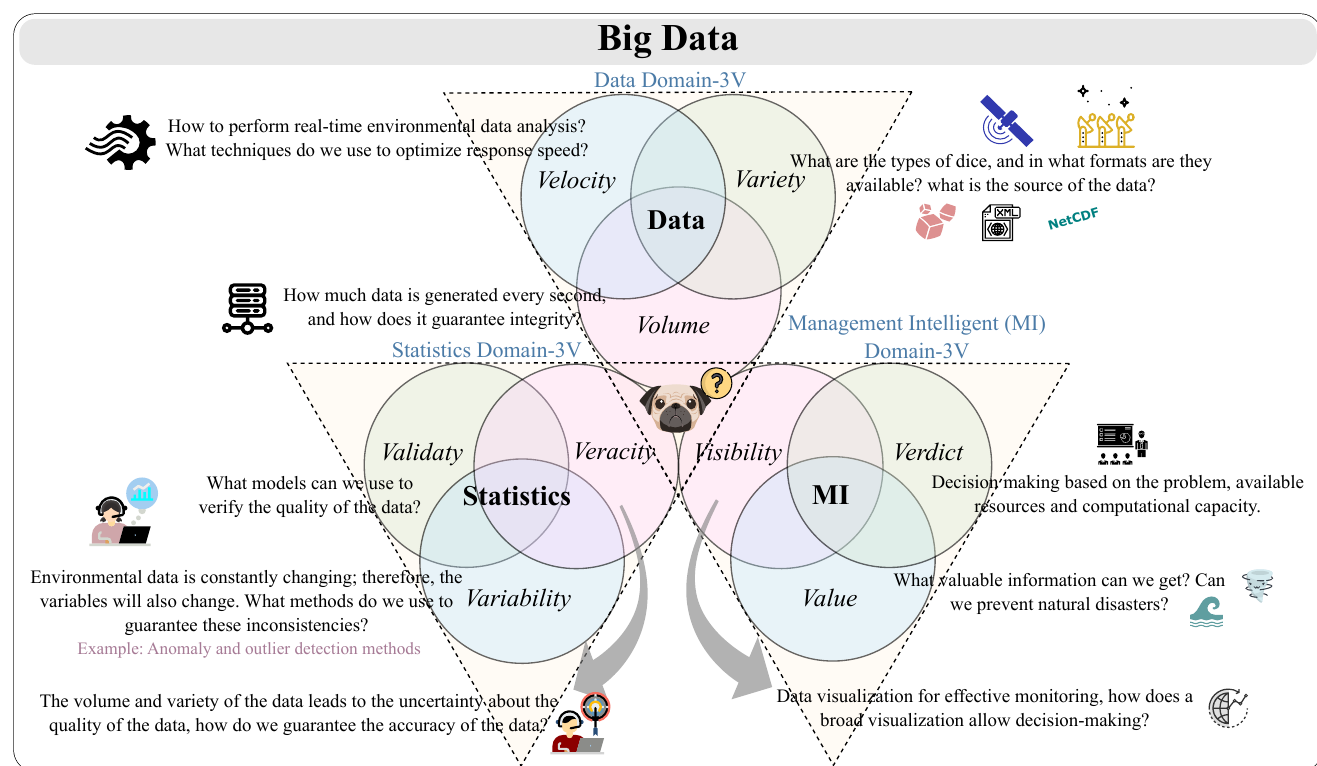
Figure 1. Perspectives of challenges presented in a Big Data context for environmental monitoring.